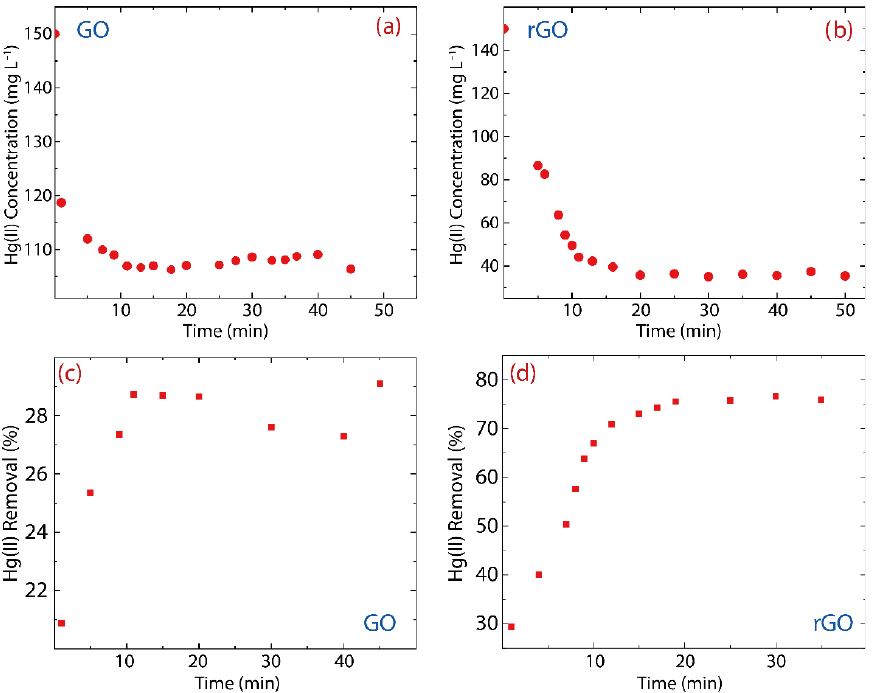
Figure 4. Adsorption kinetics and removal percentage of Hg(II) on ( a , c ) GO and ( b , d ) rGO under the Hg(II) initial concentration of 150 mg L −1 .